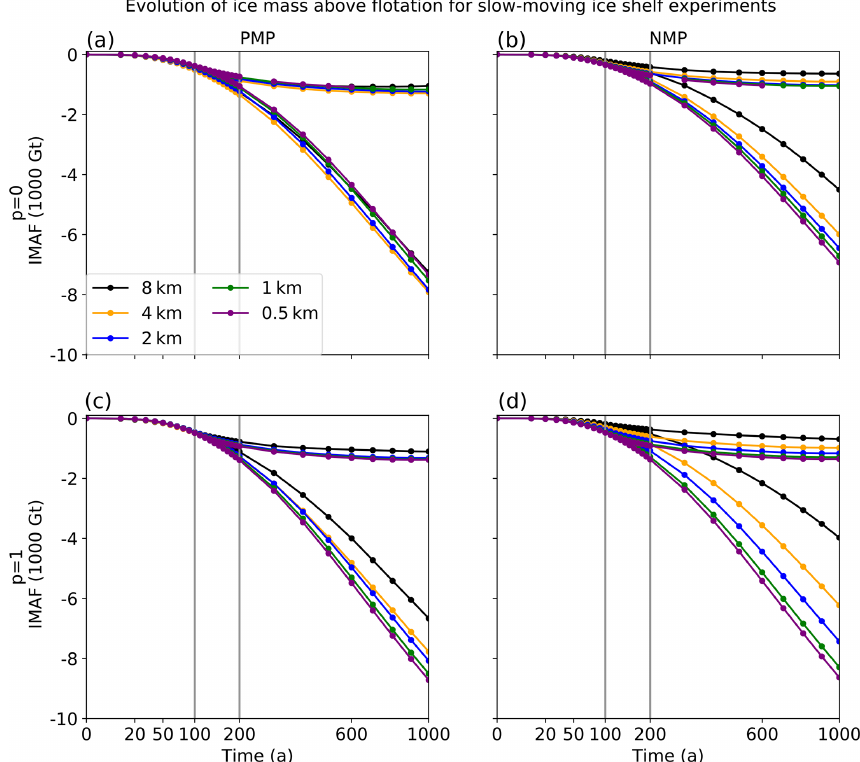
Figure 15. Evolution of IMAF relative to steady state for the full set of slow-moving ice shelf experiments, when the melt rate is the same as in the moderate-melt experiments (Sect. 4.2), but the shelf flows more slowly as a result of reduced accumulation. The layout is the same as in Fig. 11 (but note the different scale on the y